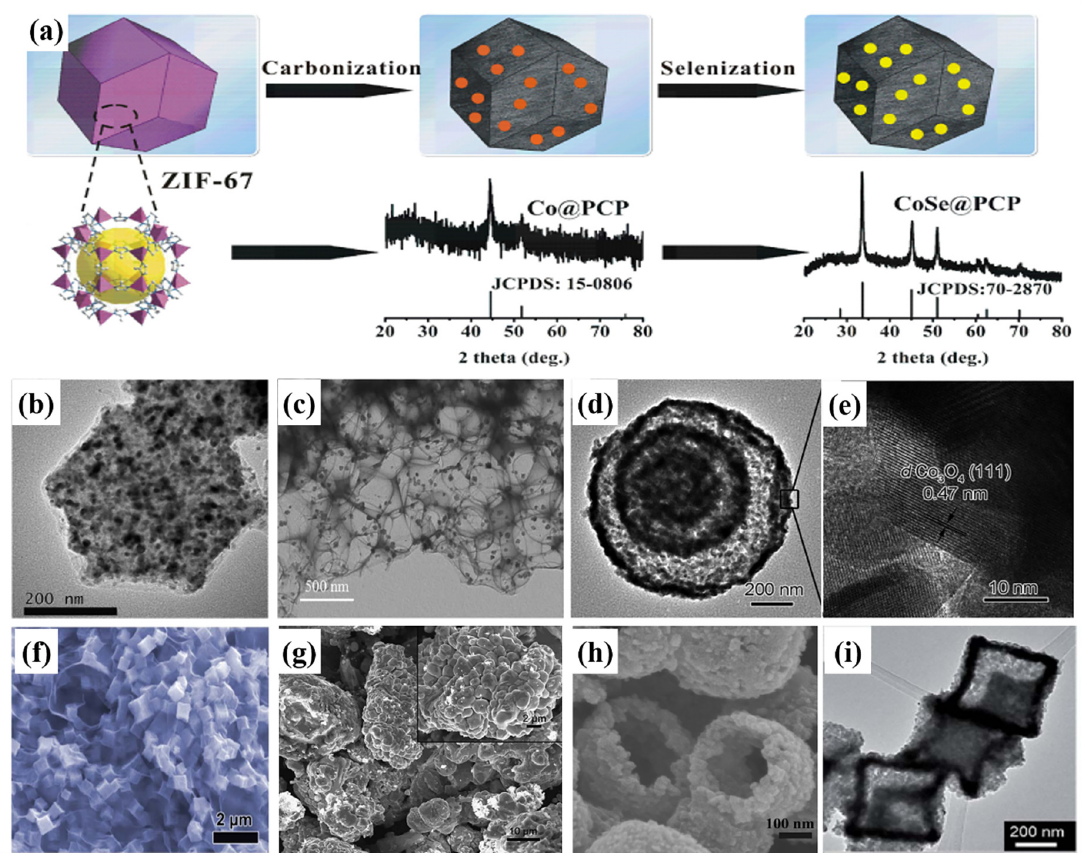
Figure 6. Preparation methods and morphology characterizations of cobalt-based composites. ( a ) Schematic illustration of the preparation of CoSe@porous carbon polyhedral (PCP). ( b ) TEM image of